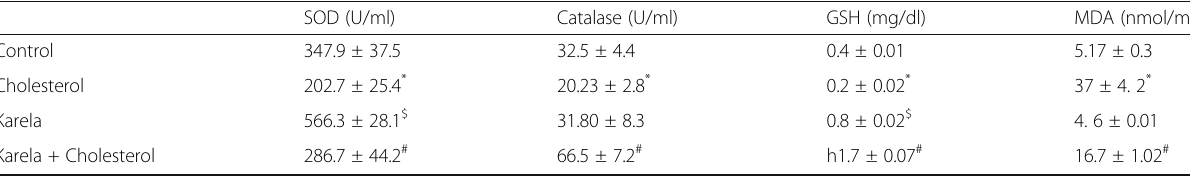
Table 3 Protective effects of Karela extract on hypercholesterolemia induced changes in antioxidants levels in Wistar rats